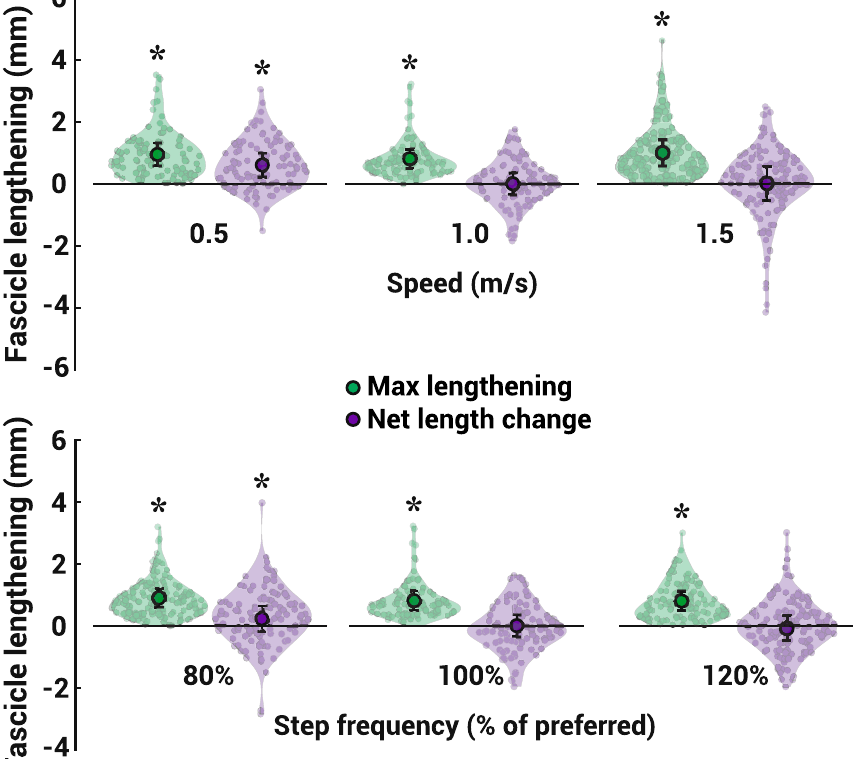
Figure 2. TA fascicle length changes during early stance across different walking speeds (top) and step frequencies (bottom). Mean values with standard deviation bars are superimposed on violin plots representing the maximum fascicle lengthening (green) and the net change in fascicle length (purple) observed for every step of every subject. Asterisks above violin plots indicate significantly greater than zero (α <